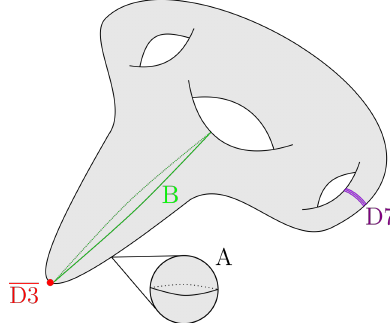
Figure 5 . In purple we have depicted D7 branes wrapping a distant 4 cycle in the bulk. Such 7-branes can support chiral matter and in the usual assumption that the SUSY breaking down the throat decouples from the bulk, one finds a conflict with the FL